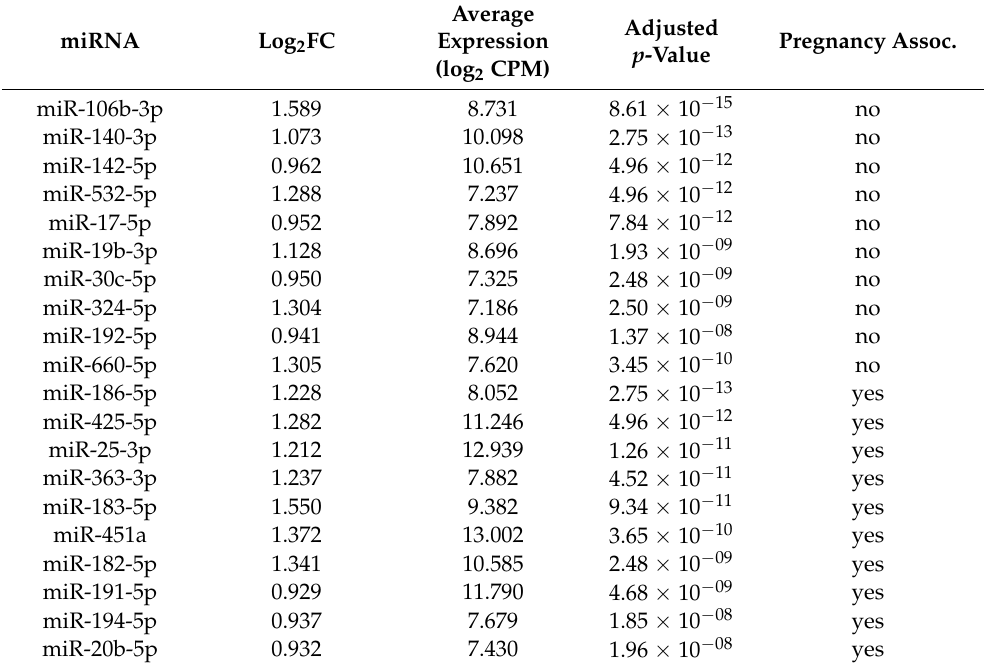
Table 2. Twenty miRNAs with a general-use plasma haemolysis signature set. To remove confounding effects within our pregnancy-specific dataset, we identified a subset of 10 abundant miRNAs that were invariant with respect to pregnancy. miRNA Log 2 FC